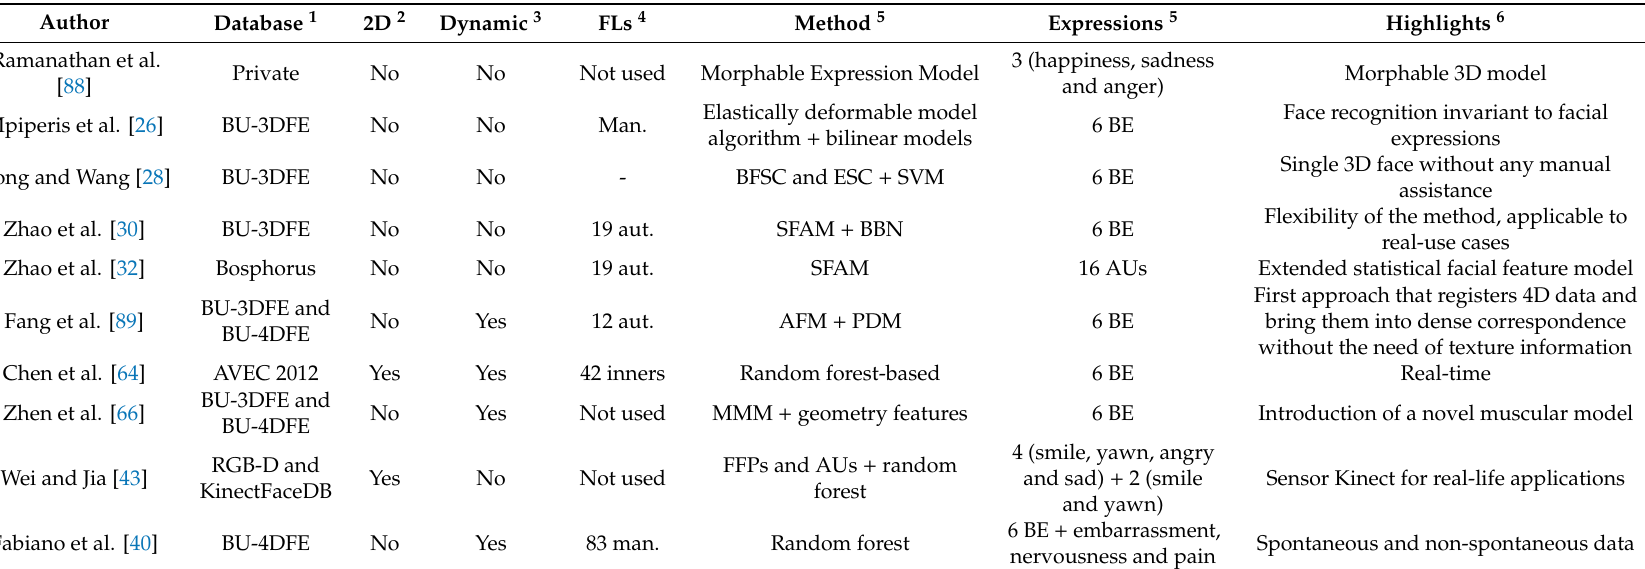
Table 3. Model-based